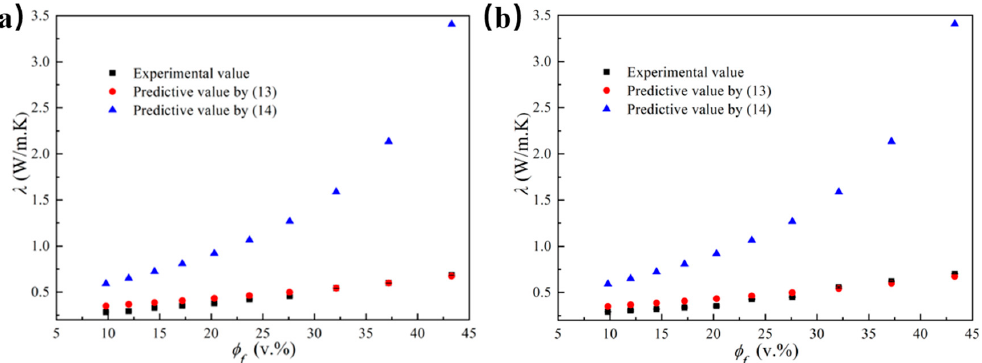
Figure 9. The thermal conductivity of LLDPE/Al 2 O 3 composites with different Al 2 O 3 diameters obtained from prediction model and experiment versus the volume fractions of Al 2 O 3 particles: ( a ) for 5 µ m; ( b ) for 40 µ m.